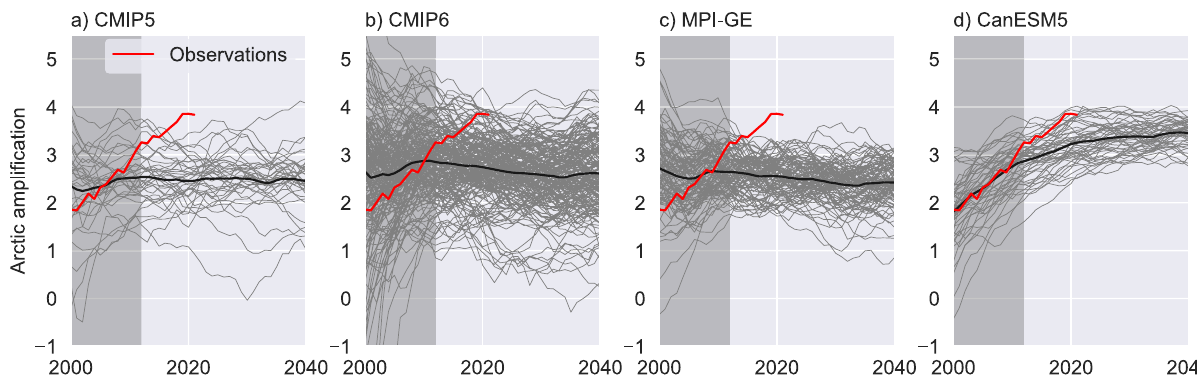
Fig. 3 The 43-year Arctic ampli fi cation ratio in observations and climate models. The 43-year Arctic ampli fi cation (AA) ratio derived from ( a ) CMIP5, ( b ) CMIP6, ( c ) MPI-GE and ( d ) CanESM5 realizations (thin grey lines) for all 43-year periods ending in 2000 – 2040. The x-axis represents the ending year of the 43-year AA ratios. Thick black lines represents the ensemble mean AA, calculated as a mean of ratios, not ratio of means. Observations (red lines) extend to 2021. 43-year AA ratios starting after 1970 and ending by 2040 are considered in the probability calculations (Section “ Likelihood of observed Arctic ampli fi cation 1979 – 2021 in climate model simulations ” ) and shown with light background. The Arctic is de fi ned as the area north of 66.5 ∘ N.